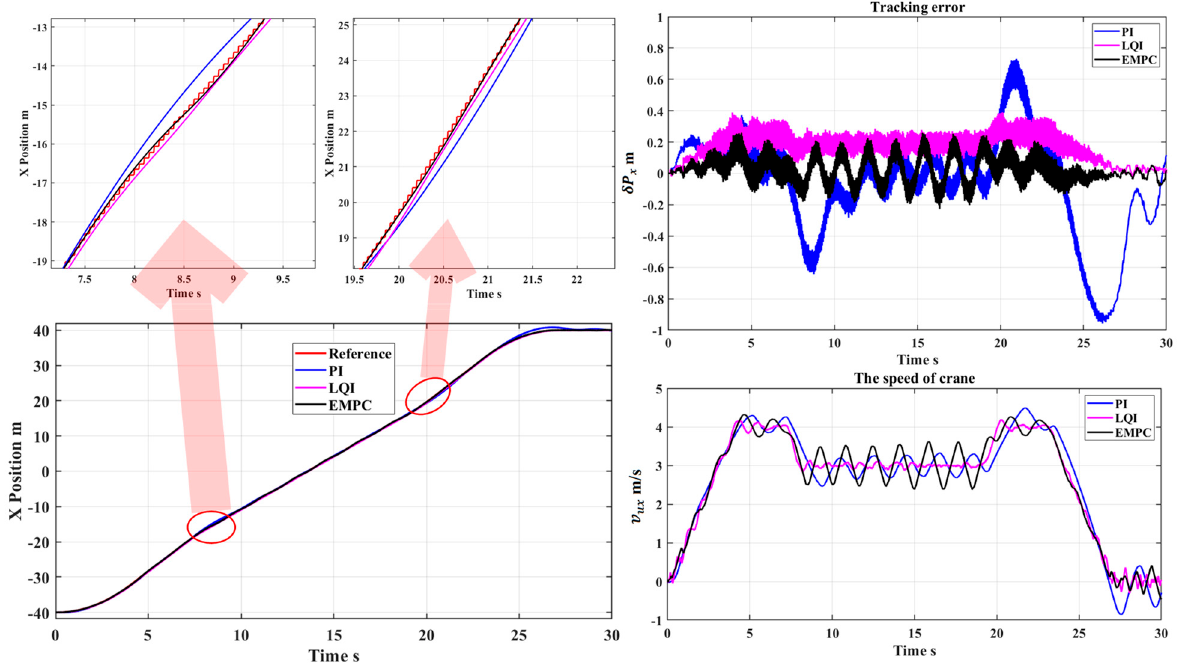
Figure 9. The simulation results’ comparison of tracking path one used the PI, LQI, and EMPC controllers. The figures present the following results: the results of the crane tracking desired path one in the X direction; tracking errors δ P x between the crane’s position and the desired position along path one in the X direction; the crane speed v ux of tracking path